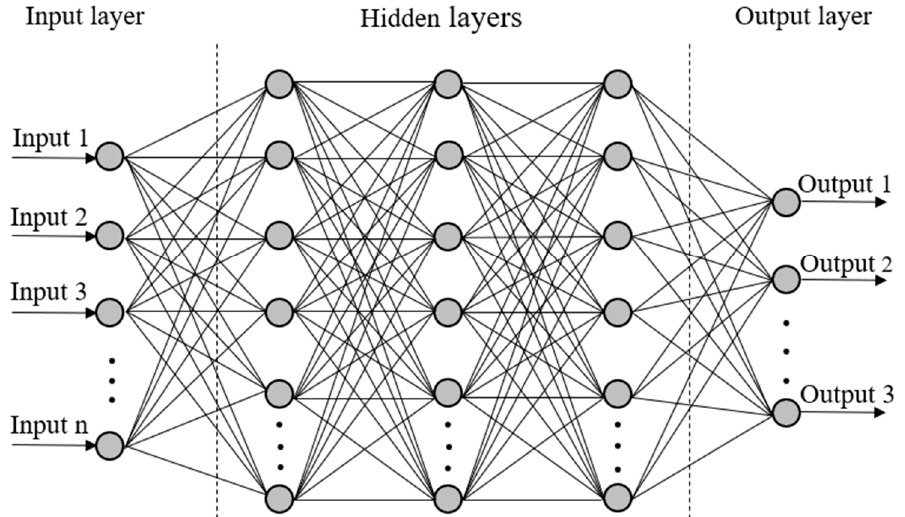
Figure 1. A schematic representation of an artificial neural network.